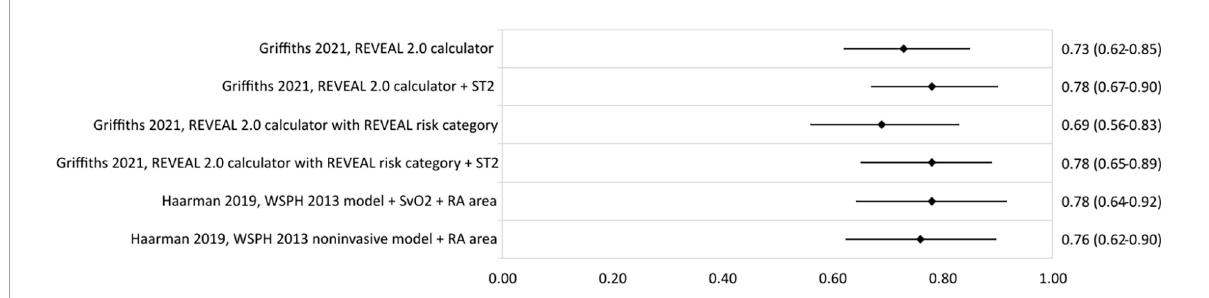
FIGURE6 C-statistic (95% CI) of risk stratification models used in pediatric PAH. ST2, soluble suppressor of tumorigenicity-2; SvO2, mixed venous oxygen saturation; RA area, right atrial